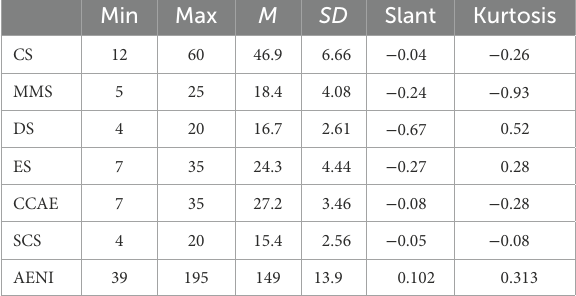
TABLE 7 Descriptive statistics of AENI and PROKOS ( N =